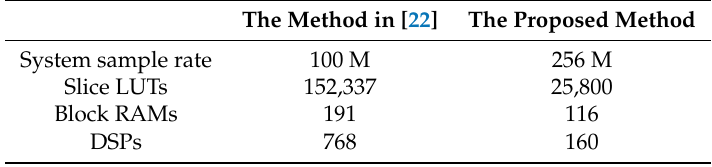
Table 1. Hardware resource usage of a 2 × 2 MIMO channel